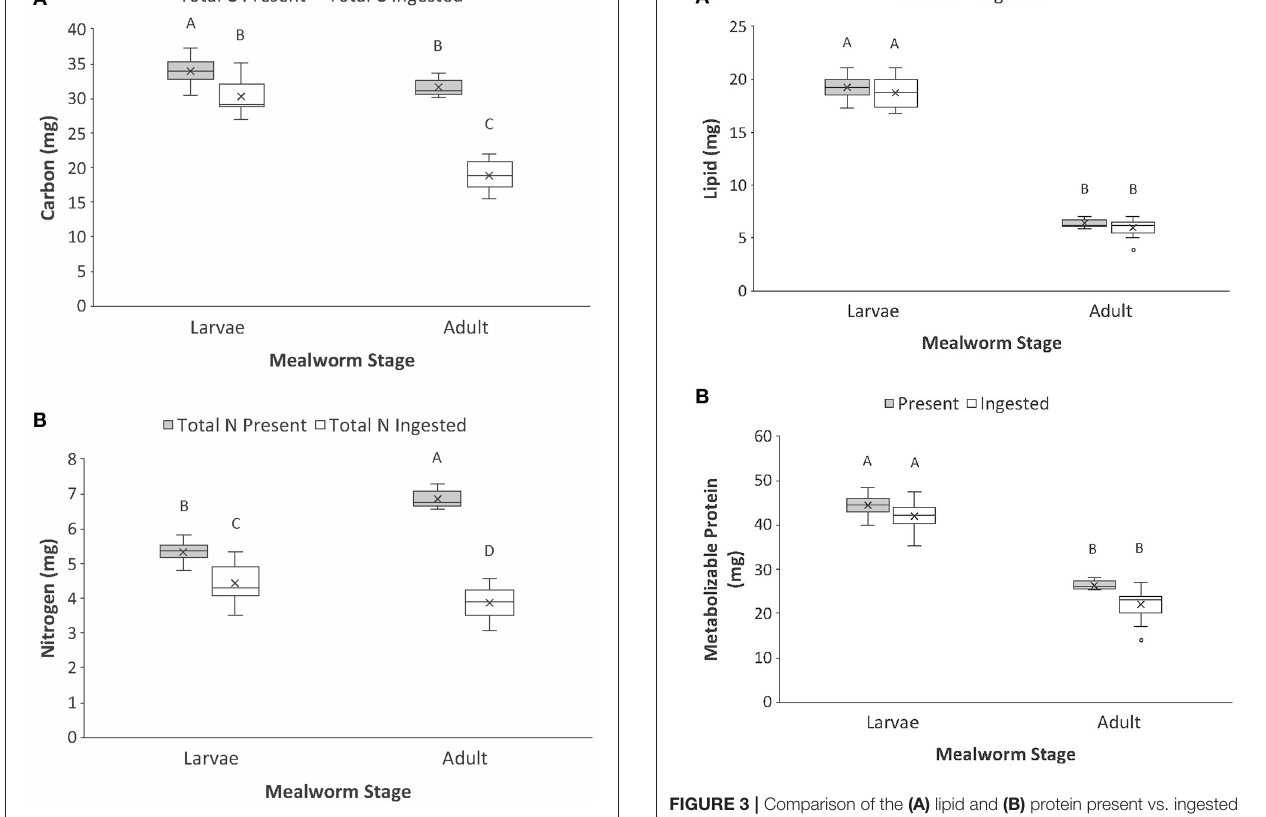
FIGURE 2 | Comparison of the (A) total carbon and (B) total nitrogen present vs. ingested by spiders when feeding on larval and adult mealworm beetles. Boxplots display the interquartile range (the box), median (line in the box), mean (x in the box), minimum (lower whisker), maximum (upper whisker), and any outliers (additional points). Treatments with different letters are significantly different from each other in post hoc analyses.